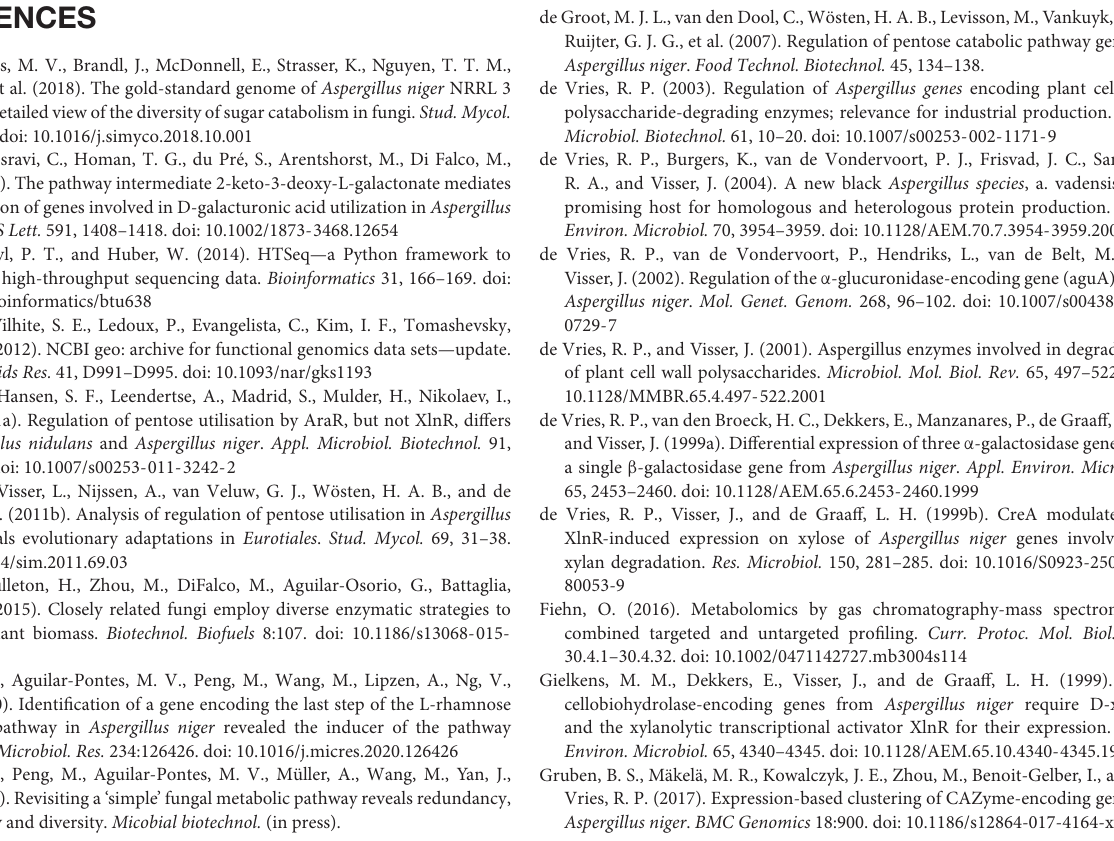
Supplementary Table 1 | Expression levels (FPKM) of catabolic genes during growth on wheat bran (WB) and sugar beet pulp (SBP) in the A. niger reference strain (N593 (cid:49) kusA) and the PCP deletion mutants. Supplementary Table 2 | Expression levels (FPKM) of genes encoding CAZymes during growth on wheat bran (WB) and sugar beet pulp (SBP) in the A. niger reference strain (N593 (cid:49) kusA) and the PCP deletion mutants. Supplementary Table 3 | Comparison between the transcriptome and exo-proteome analysis of the A. niger reference strain (N593 (cid:49) kusA) and the PCP deletion mutants grown on wheat bran (WB) and sugar beet pulp (SBP) for 2, 8, and 24 h. Transcripts were considered differentially expressed if the DESeq2 fold change was > 2 (red font) or < 0.5 (green font) and Padj < 0.01. Similarly, for an identified protein to be considered differentially produced, the requirement was a